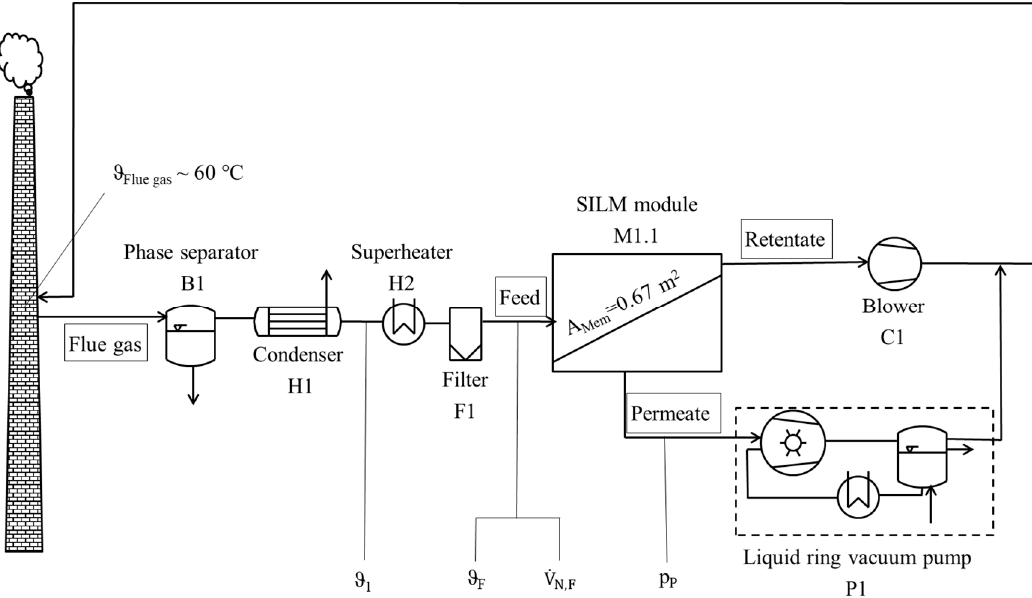
Figure 6. Simplified flow sheet of gas permeation pilot plant.